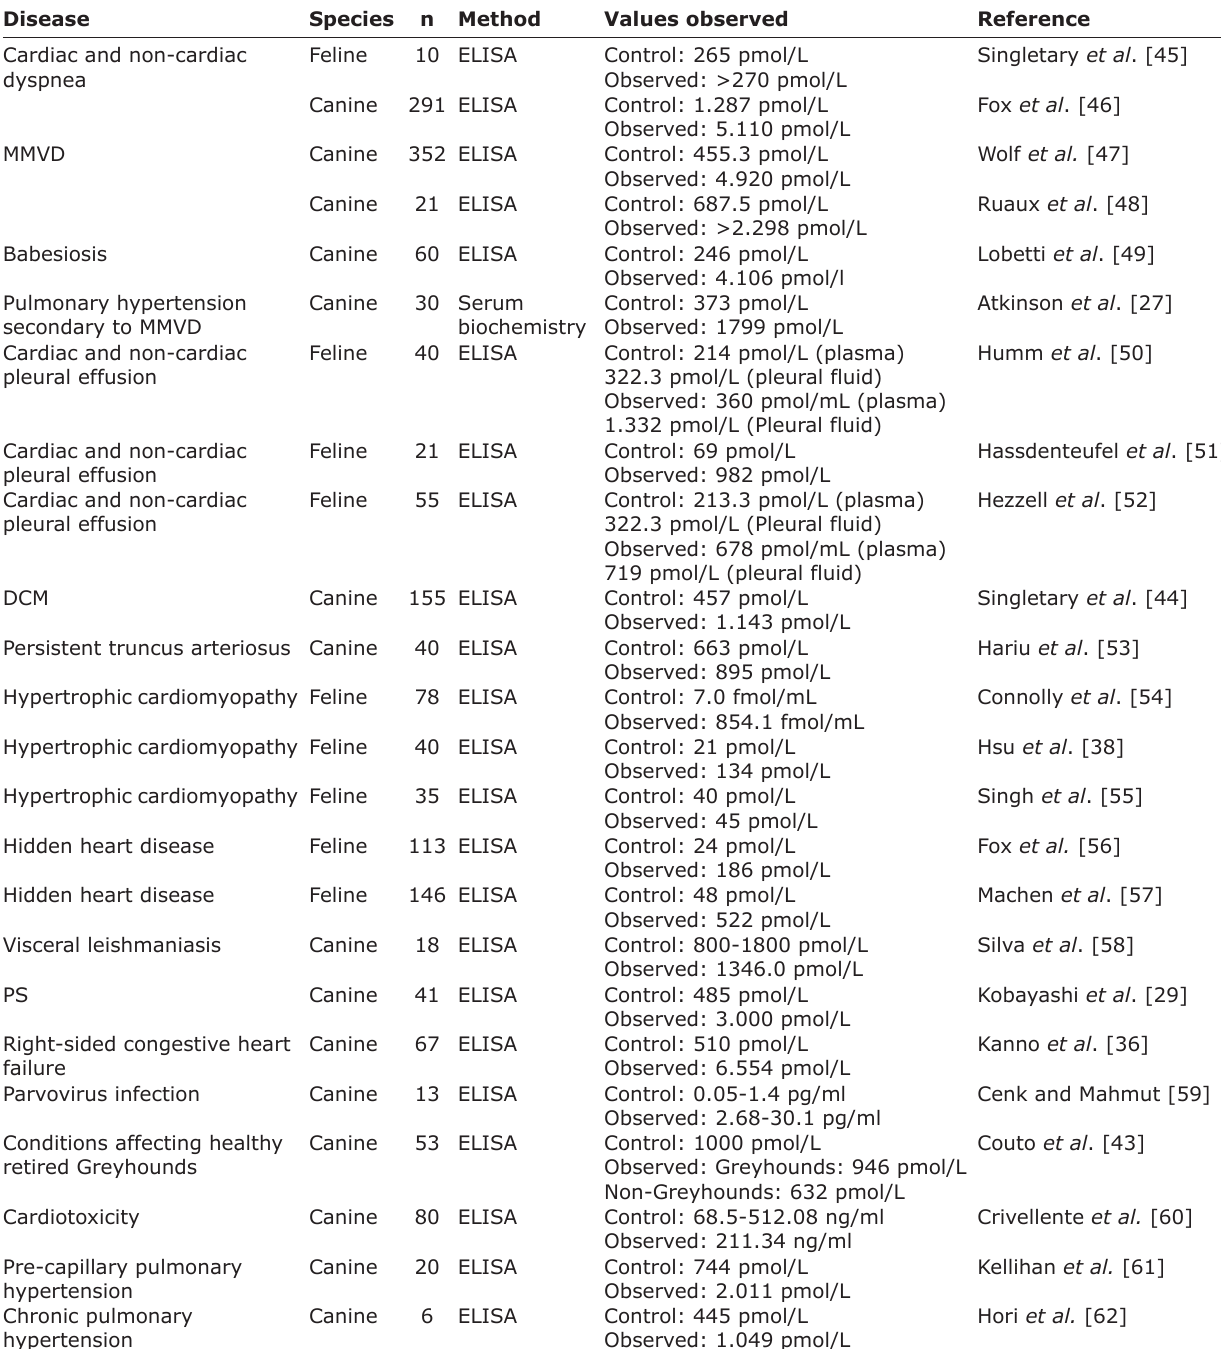
Table-3: Different applications of BNP in the diagnosis of cardiac and non-cardiac conditions in dogs and cats.